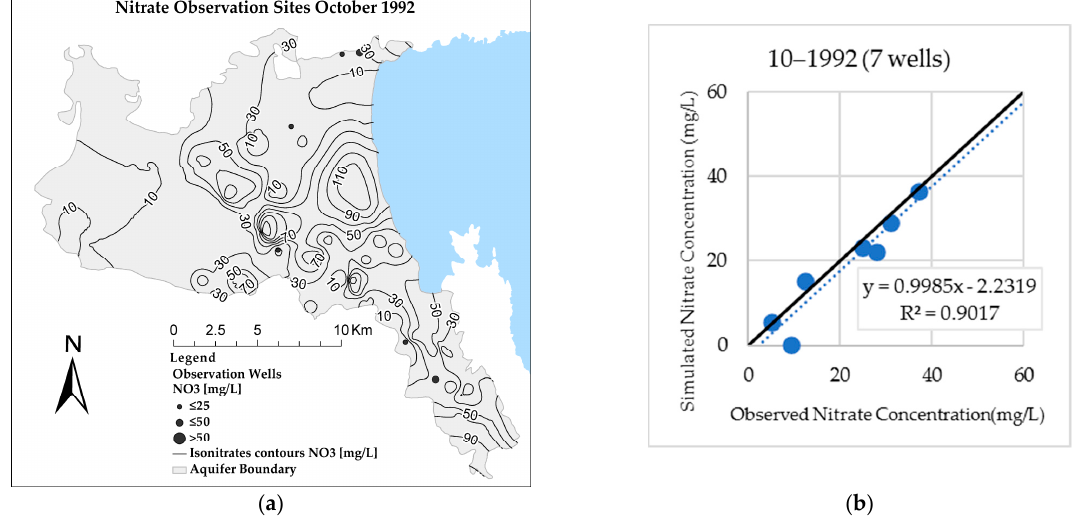
Figure 17. ( a ) Isonitrates contours for October 1992 and ( b ) scatterplot of simulated against observed nitrates concentration values.